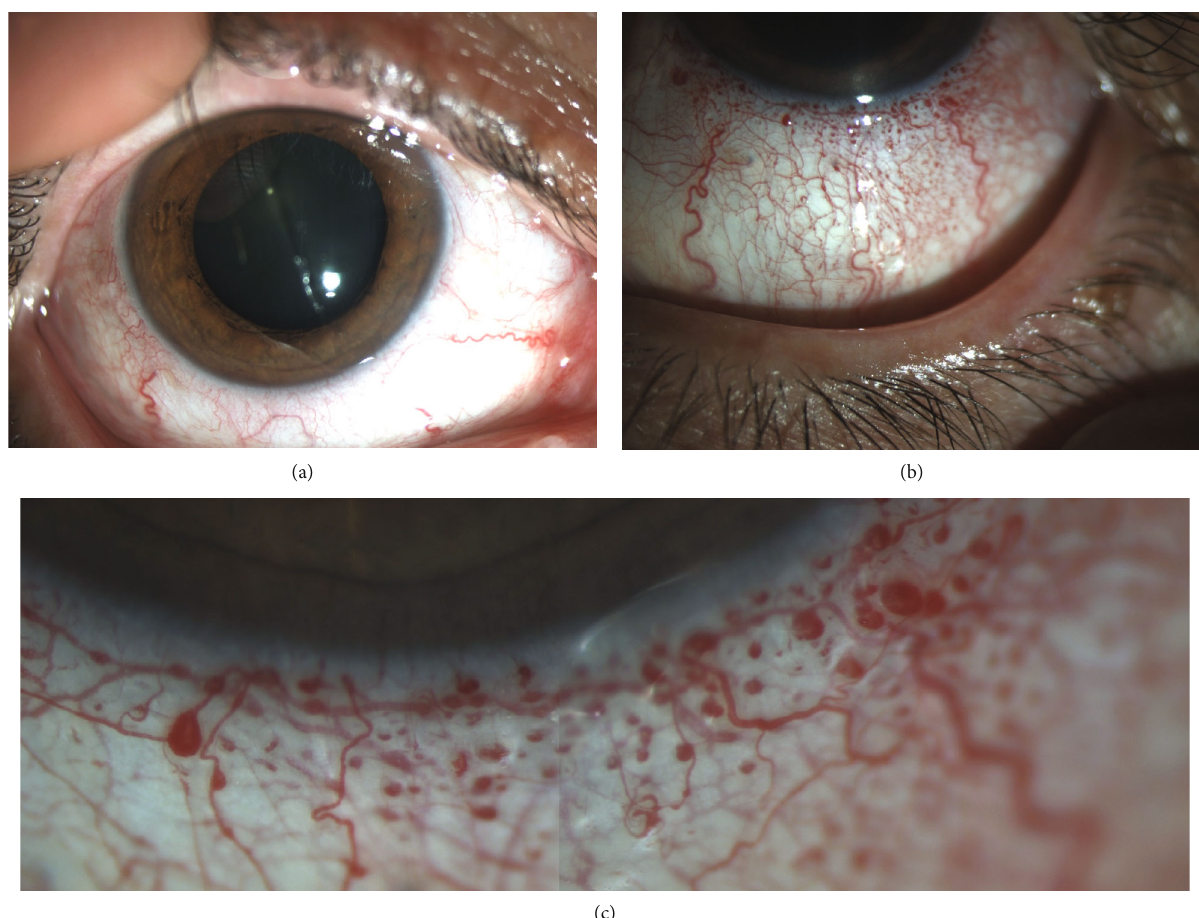
Figure 1: (a) Anterior segment picture of the right eye depicting normal conjunctival and episcleral vessels. (b, c) Anterior segment picture of the left eye depicting the conjunctival and episcleral vascular dilation, tortuosity, and conjunctival